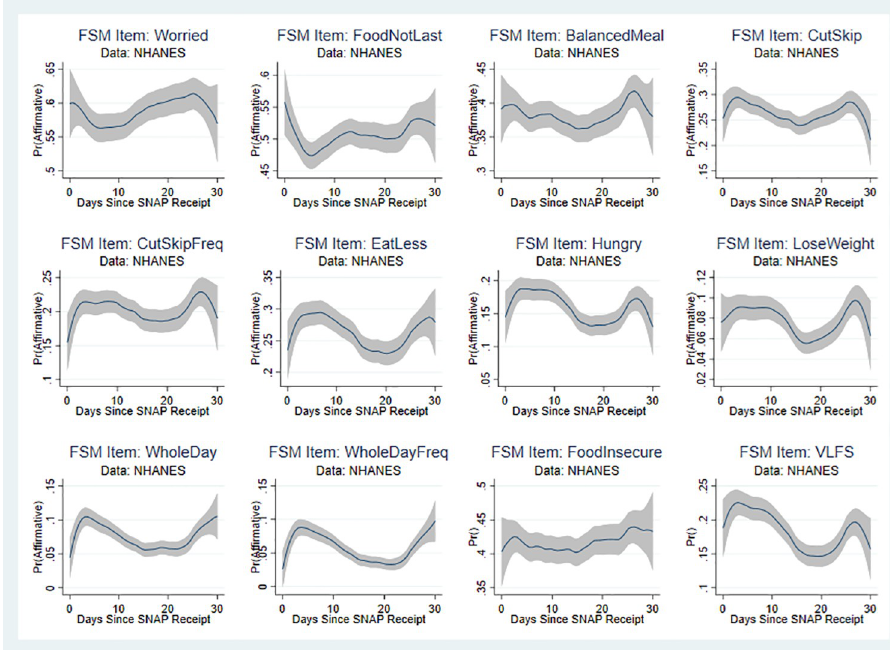
Fig 1. Non-parametric regressions: Days since SNAP and food security items. Source: Authors’ calculations using NHANES data. N = 7,433. Regression estimates are weighted.